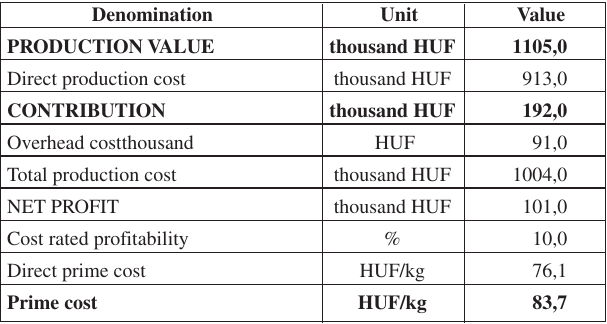
Table 4. Profit in sour cherry productionn